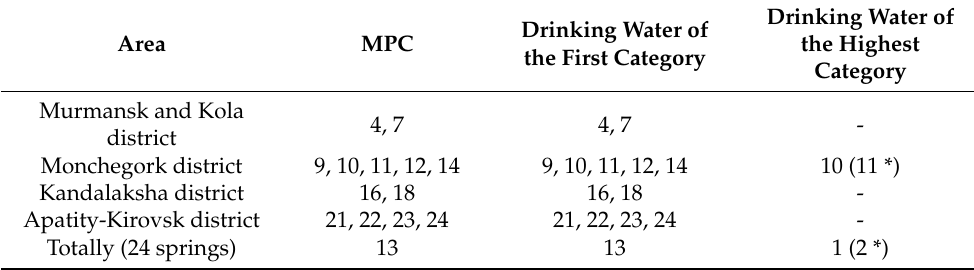
Table 6. Springs’ compliance with the standards.